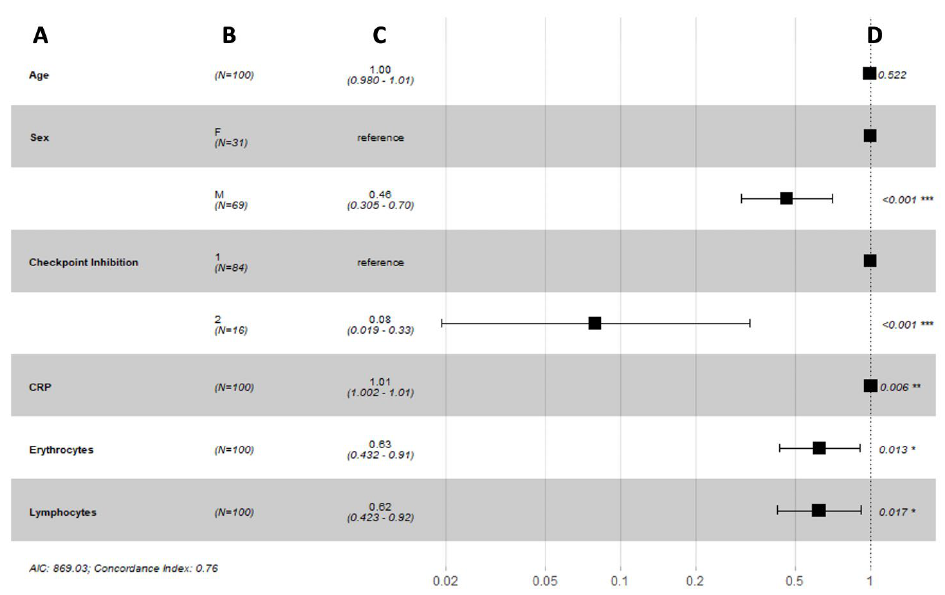
Figure 7. Forest plots summarizing the results of a Cox proportional hazard model analysis of progression-free survival with time-varying covariates: ( A ) variable; ( B ) number of patients; ( C ) hazard ratio (95% CI); ( D ) p -value. Abbreviations: F = female, M = male, 1 = single ICI, 2 = double ICI, CRP = c-reactive protein, AIC = Akaike information criterion. *, ** and *** indicate significance at the 0.1, 0.05 and <0.01 levels retrospectively.